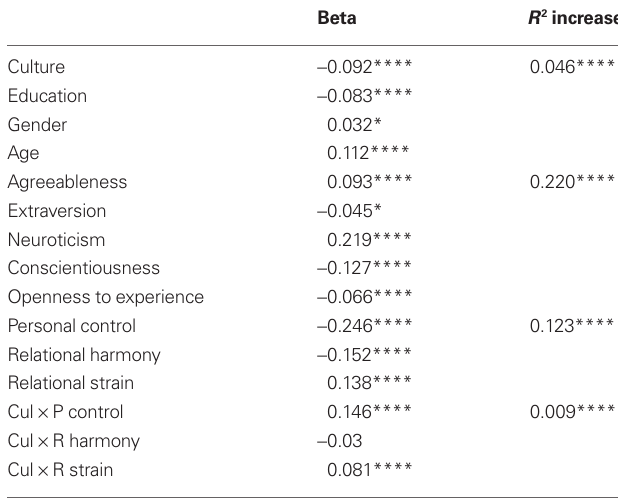
Table 2 | Summary of regression predicting perceived constraint as a function of demographics, personality, self, and culture and